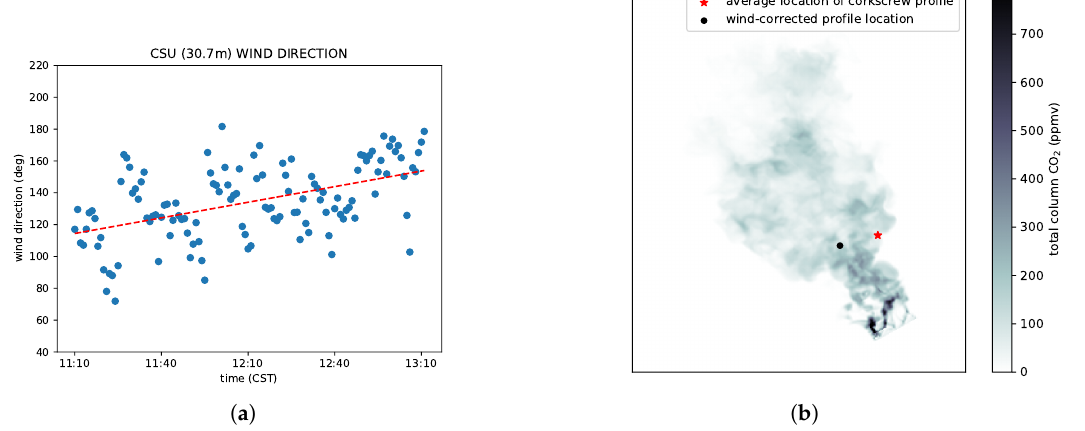
Figure 6. The effects of changing mesoscale wind conditions on plume observations ( a ) Observed change in 30 m wind direction prior to and during the burn. Significant linear trend is shown with a red dashed line. ( b ) Top view of modeled smoke plume during the “corkscrew” maneuver by the instrumented aircraft. Black dot and red star indicate the average location of the “corkscrew” profile from flight with and without wind-correction,